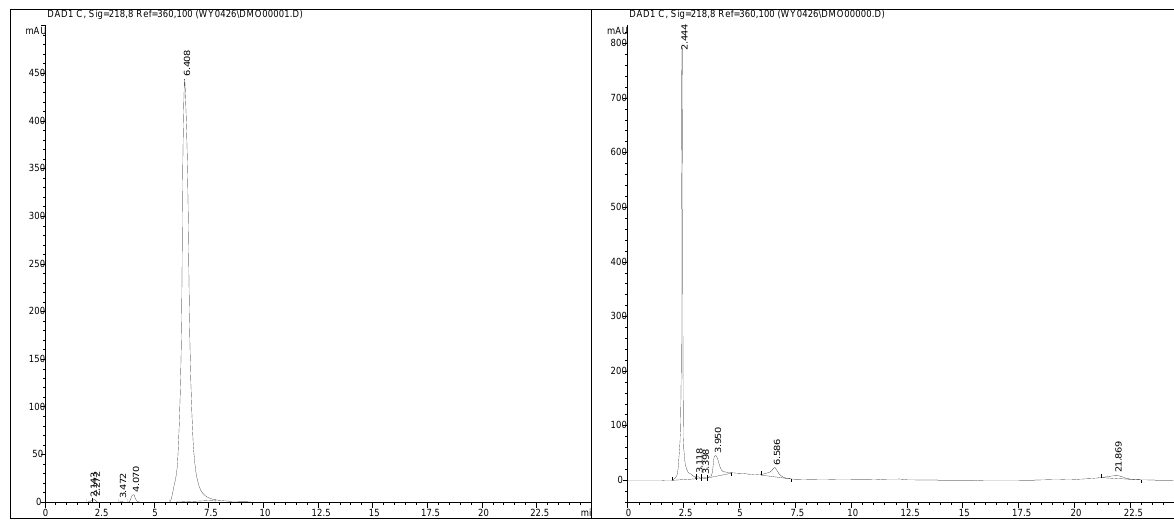
Figure 3. The detection of DON using HPLC (A: The peak time of DON was 6.408 min; B: The peak time of product was 2.444 min). X axis = time (min), Y axis =